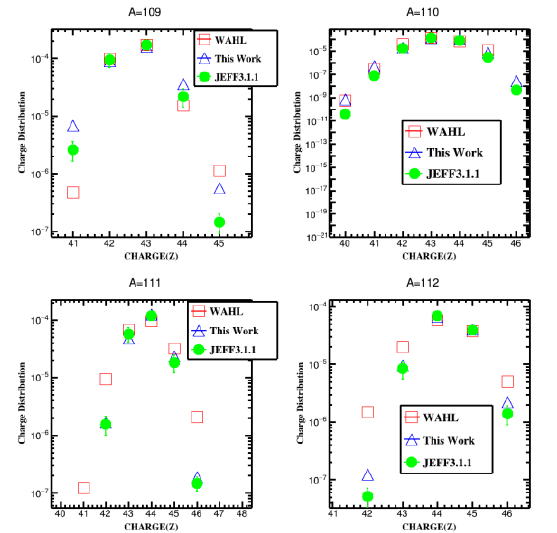
Fig. 10. The comparison of the charge distribution calculated using the Wahl’s systematic (in red) and direct-Zp parameterization (in blue) with the JEFF-3.1.1 evaluation (in green) for the masses 109, 110, 111, 112